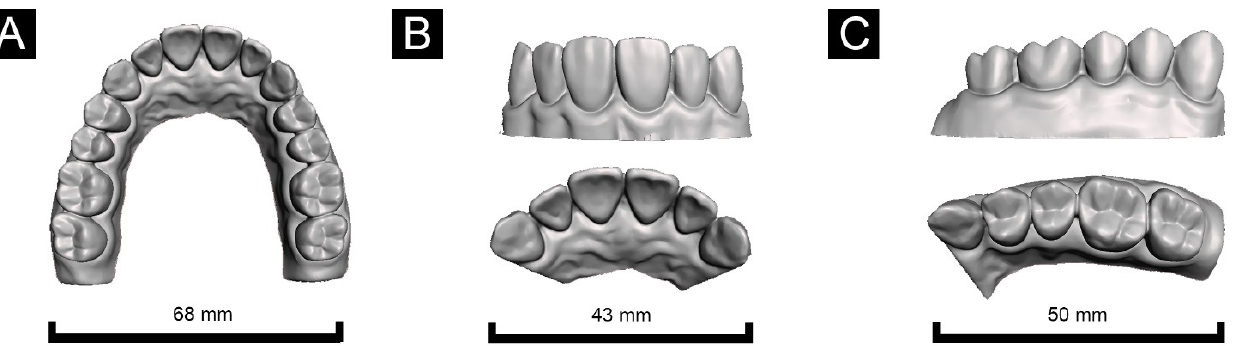
Figure 2. Designs of the ( A ) full-arch model, ( B ) anterior partial-arch model, and ( C ) posterior partial-arch model. Partial areas of the teeth and gingiva were designated and used to evaluate printing accuracy.